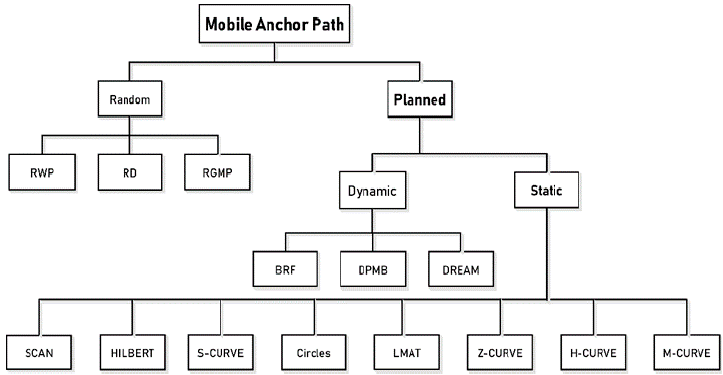
Figure 3. Different path models for MANAL in WSNs.